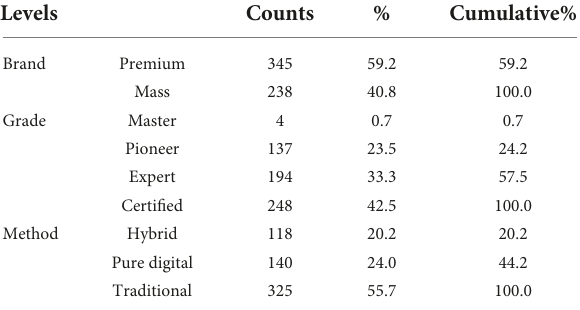
TABLE 3 Frequency: brand, sales consultant grade, and training method.